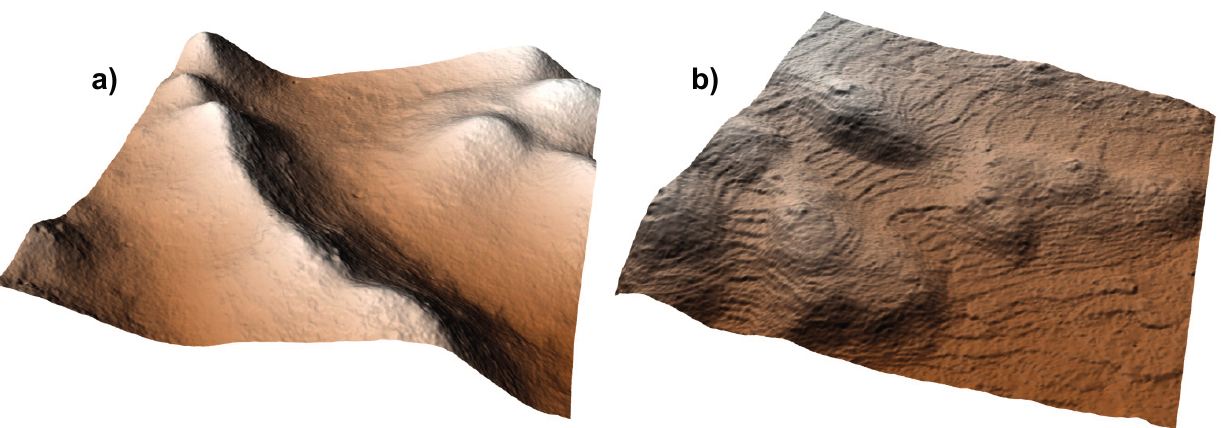
Figure 3. Renditions of 500 × 500 m ( a ) non-terraced and ( b ) terraced areas from Caracol. Locations of these example areas are shown in Figure 2.